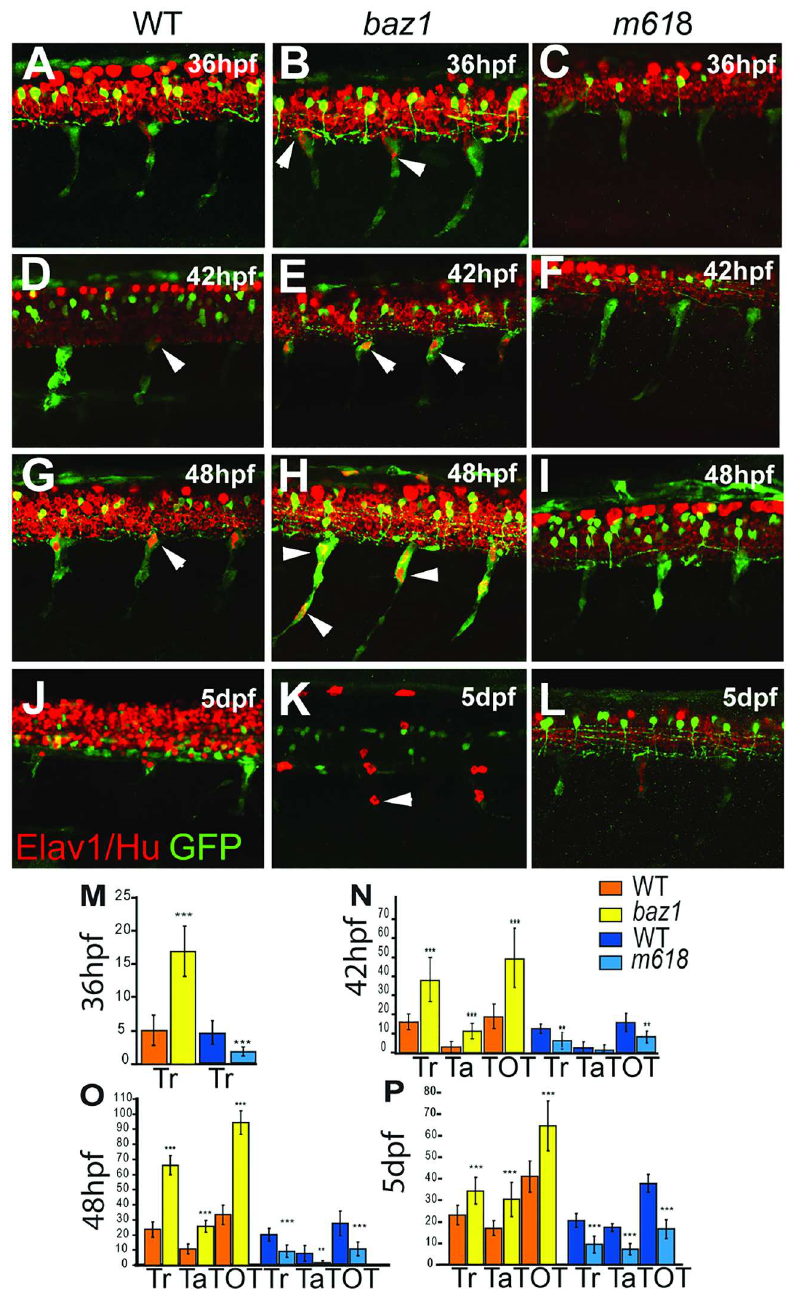
Fig 3. Medial pathway neural precursors undergo precocious and supernumerarydifferentiation into neurons in baz1 mutants. Confocal images of developingtrunk DRGs of WT (A, D, G, J), baz1 (B, E, H, K) and m618 mutants (C, F, I, L) showingElav1/Hu(red) and sox10 : GFP (green) at each of 36 (A-C), 42 (D-F), 48 hpf (G-I) and 5 dpf (J-L). Arrowheadsindicate subset of Elav1/Hu + DRG sensory neurons. M-P) Counts (mean ± s.d.) of trunk (Tr) and tail (Ta) and total (TOT) Elav1 + cells in DRGs of baz1 (yellow) and m618 (blue) mutants and their respective WT siblings.Significantly elevated numbers of neuronsare indicated(two-tailed Student’s t test; ** , p < 0.01; *** , p < 0.001).Note in panels J-L) that variableprominence of Elav1/Hudetection in spinal cord is an artefact of antibodypenetrationinto CNS at this late stage. Scale bar, 50 μ m.